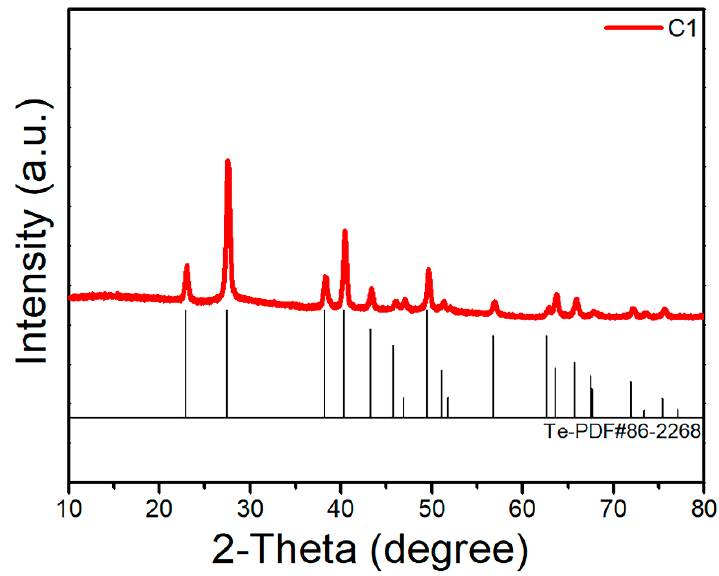
Figure 3. XRD diffraction patterns of C1 sample.